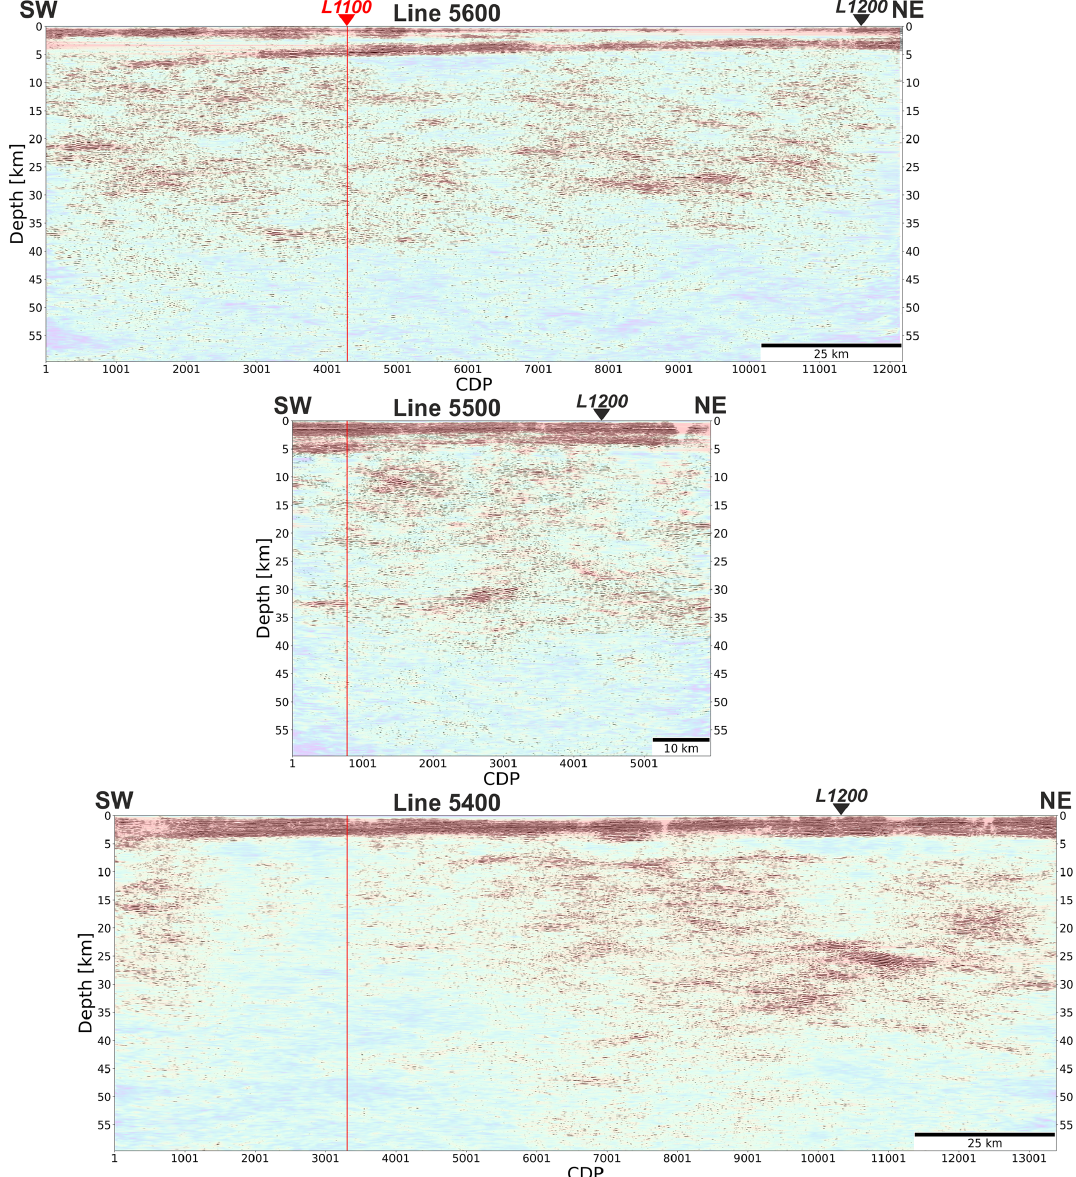
Figure 5. Final migrated depth-converted section along PolandSPAN ™ profiles 5600, 5500, and 5400 (envelope and amplitude combined plot as in Fig. 4b). Profiles are centred at the intersection with line 1100 (vertical red